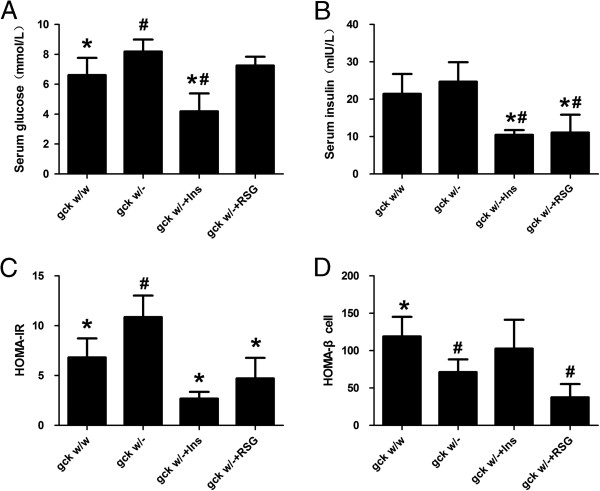
Effect of rosigitizone and insulin on fasting glucose (A), insulin (B), HOMA-IR (C) and HOMA-β-cell (D) levels in 60-week old gckw/– mice. Glucose and insulin levels as well as calculated HOMA-IR and HOMA-β-cell levels are shown for 60-week old wild-type (gckw/w) and liver-specific gck knockout (gckw/–) mice as well as gck knockout mice treated with insulin or rosigitizone for 4 weeks. n = 6 for all samples. Asterisk (*) refers to statistical significance (P < 0.05) in comparisons with gckw/– mice, while #refers to comparisons with gckw/w mice.